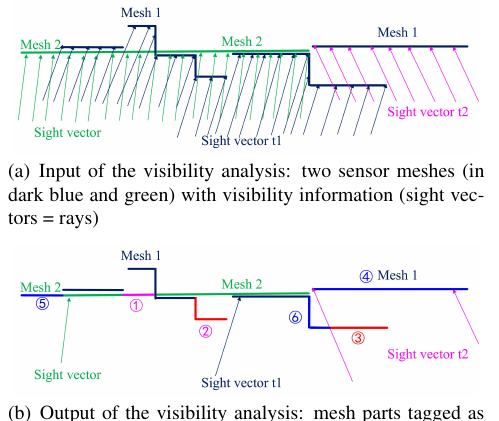
Figure 8. A 2D view (from above) of visibility